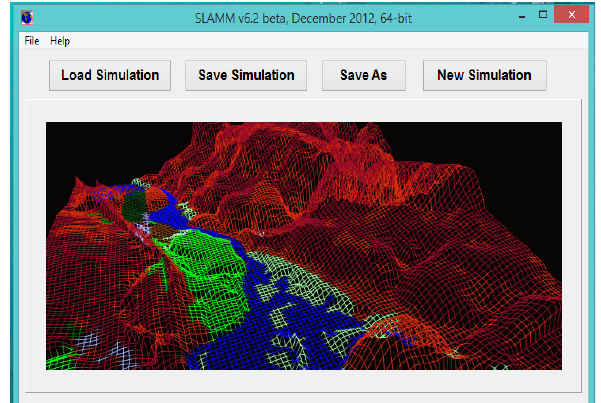
Figure 1: SLAMM 6.2 Opening